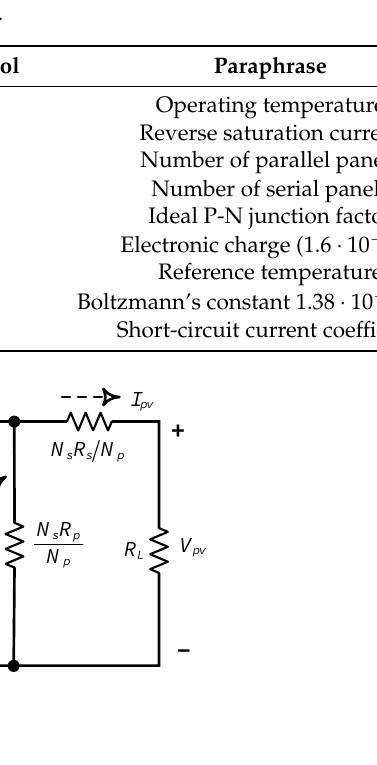
Table 1. Symbols and paraphrase for the PV panel.